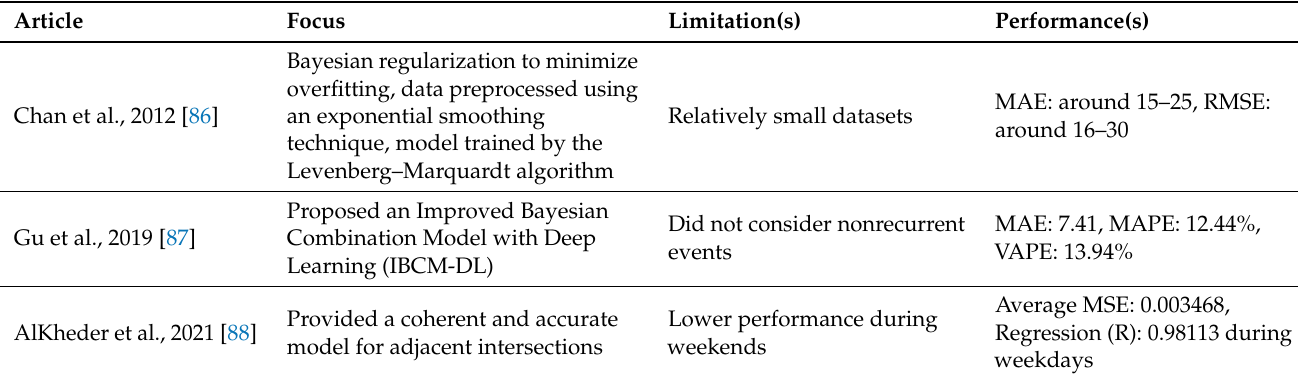
Table 14. Summary of the works found using BNNs.